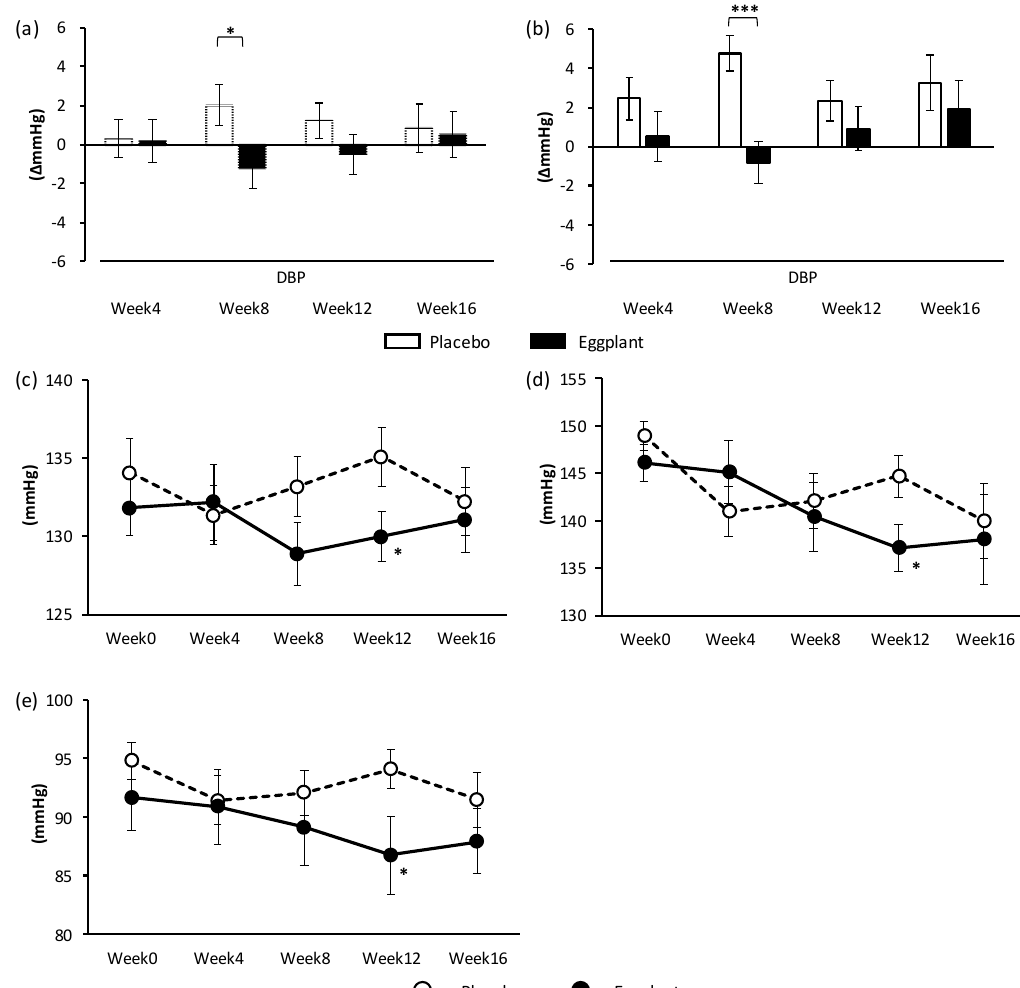
Figure 2. Changes in hospital BP (different values from week 0: ( a ) and ( b ); measured values: ( c ), ( d ), and ( e )). ( a ) DBP of all participants. ( b ) DBP of participants with normal-high BP. ( c ) SBP of all participants, ( d ) SBP of participants with grade 1 hypertension, ( e ) DBP of participants with grade 1 hypertension. Student’s t -test was conducted for data analysis. Statistical significance: * p < 0.05 and *** p < 0.001 vs. placebo group. Values are presented as mean ± standard error. BP: blood pressure; DBP: diastolic blood pressure; SBP: systolic blood pressure.